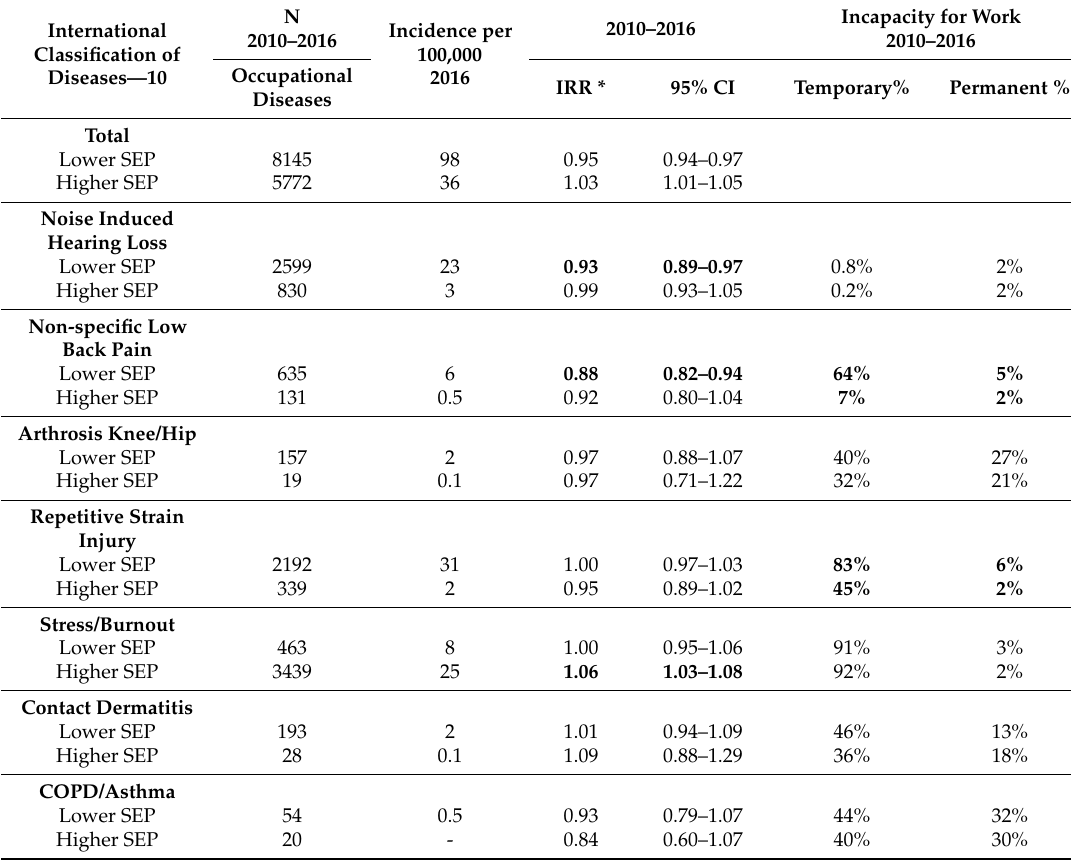
Table 1. Occupational diseases and incapacity for work among workers in lower and higher socioeconomic positions